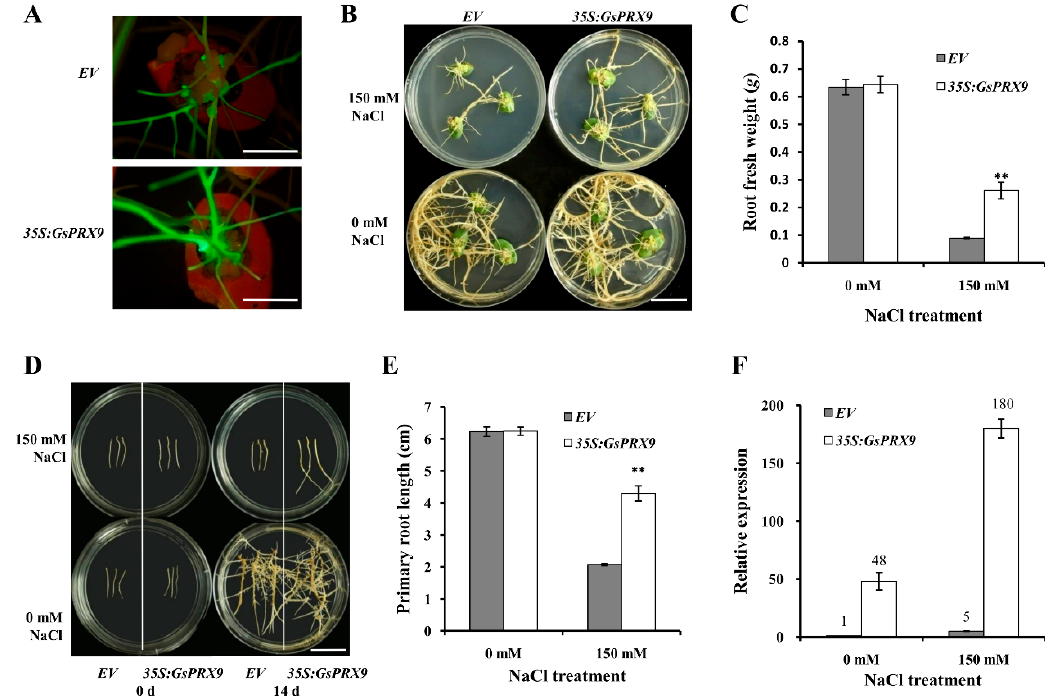
Figure 5. Salt tolerance analyses of transgenic soybean hairy roots. ( A ) Identification of positive transgenic soybean hairy roots by green fluorescence using a stereoscopic fluorescence microscope. Bar = 1 cm. ( B , C ) Phenotype and root fresh weight of transgenic soybean cotyledon hairy roots receiving 0 or 150 mM NaCl treatment for 14 days, respectively. Bar = 1 cm. ( D , E ) Phenotype and primary root length of re-generated transgenic soybean hairy roots under 0 or 150 mM NaCl treatment for 14 days, respectively. Bar = 1 cm. ( F ) The relative expression level of GsPRX9 in transgenic soybean hairy roots at 24 h after 0 or 150 mM NaCl treatment. EV represents roots with the empty vector pBinGFP4, and 35S:GsPRX9 represents roots with the recombinant vector pBinGFP4- GsPRX9 ( GsPRX9 was expressed in fusion with GFP, driven by a CaMV 35S promoter). The relative expression level of GsPRX9 in transgenic soybean hairy roots was in comparison to that in soybean hairy roots containing the empty vector under 0 mM NaCl (control). Data represent the mean ± standard deviation of four biological replications and each repeat contained at least three independent transgenic hairy roots ( n ≥ 12). ** represents significant di ff erence between EV and 35S:GsPRX9 under the same condition at the 0.01 level by Student’s t -test.